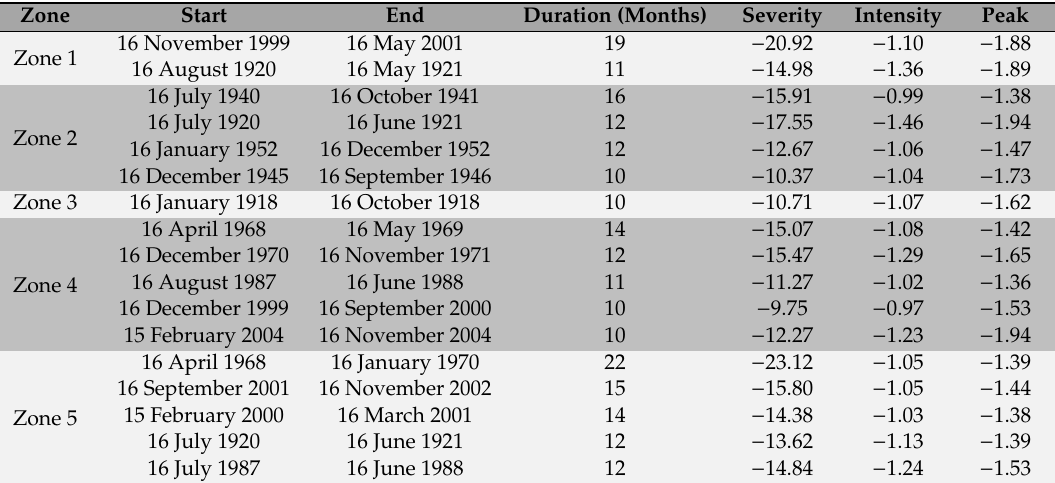
Table 2. Drought characteristics of droughts with duration ≥ 10